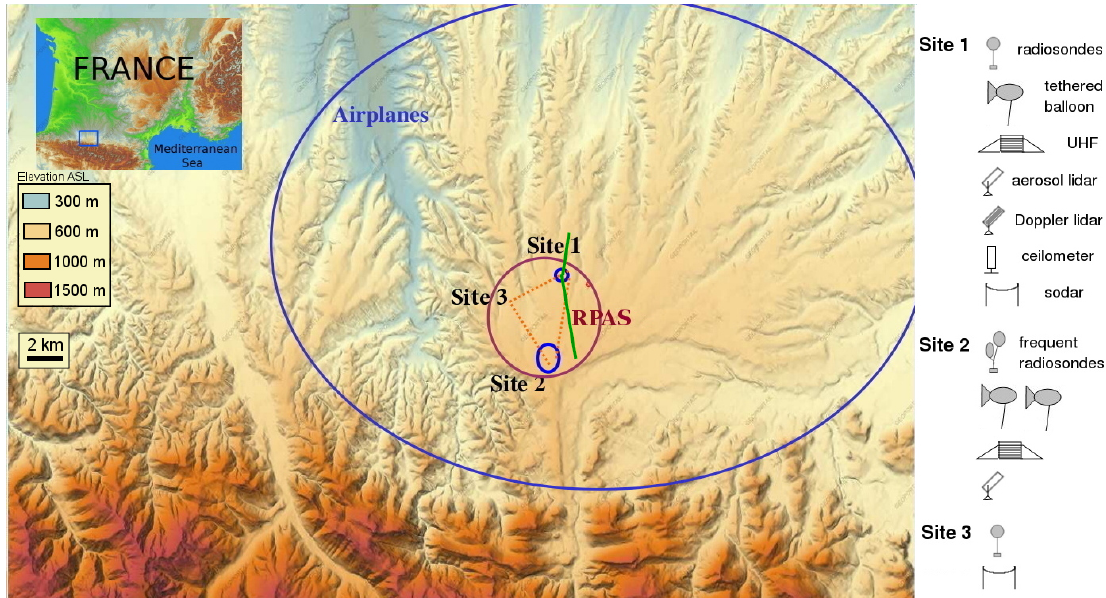
Figure 1. Experimental area. The small frame at the top-left corner situates the BLLAST experiment area (blue square) at the larger scale of the country. The large blue oval delimits the exploration area of the manned aircraft, and the smaller purple circle indicates the temporary restricted area (TRA) for the operations of the remotely piloted aircraft systems (RPASs). The orange dotted triangle locates the profiler network, and the green lines represent the paths of the two large aperture scintillometers. Instruments (other than surface stations) deployed over the three sites are schematized on the right side of the